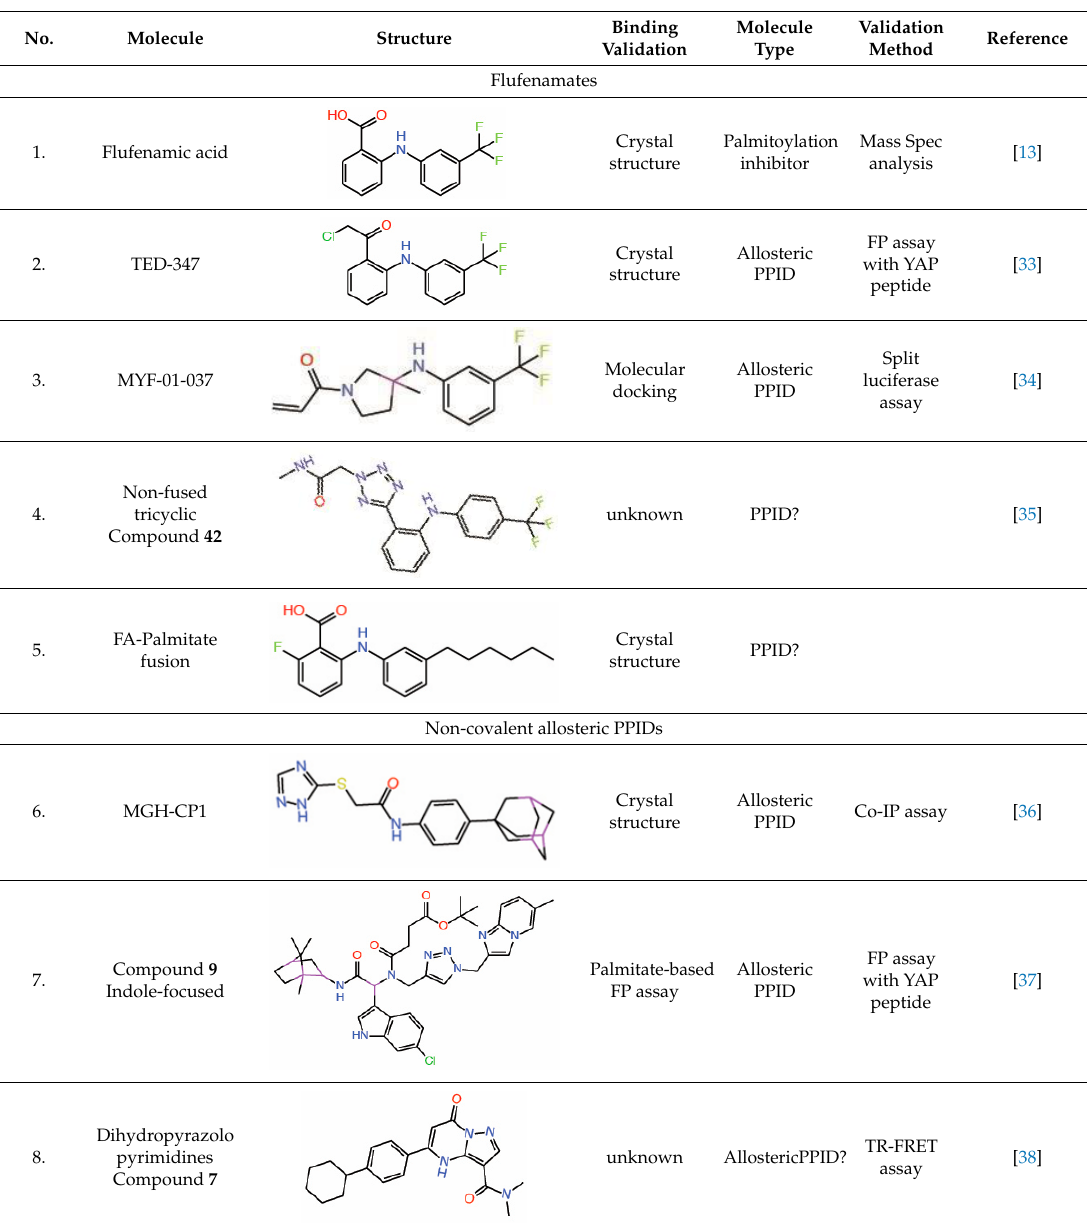
Table 2. Compounds that target the TEAD central pocket.